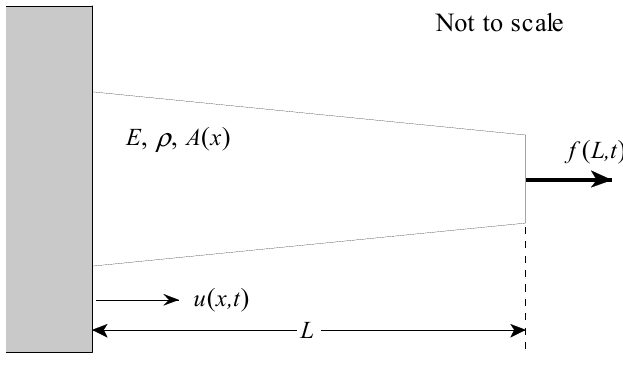
Figure 1. Fixed-free rod with a linear change of area.